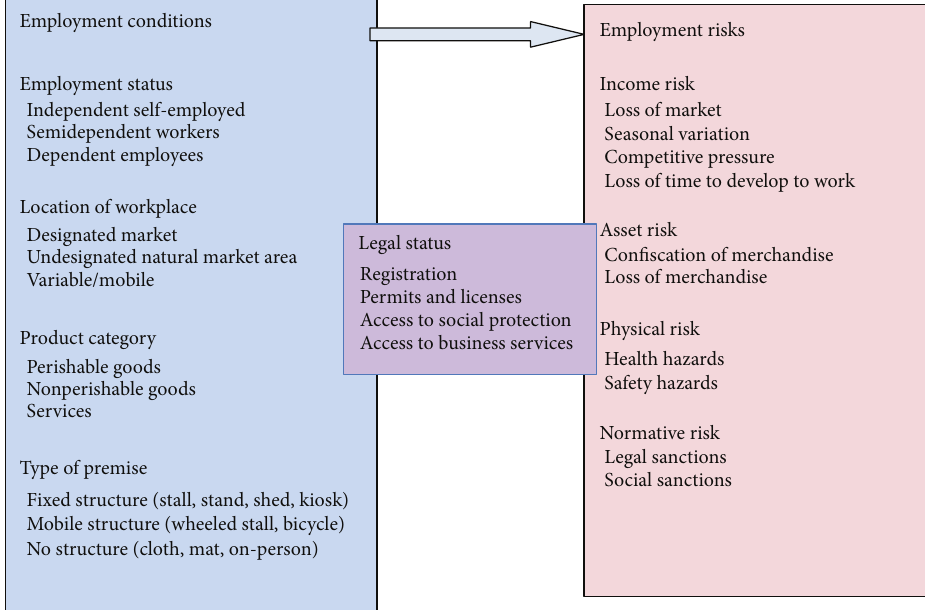
Figure 1: Employment condition and employment risk among street vendors, the number of vendor surveyed was 1137 (adapted from http://wiego.org/informal-economy/occupational-groups/street-vendors)